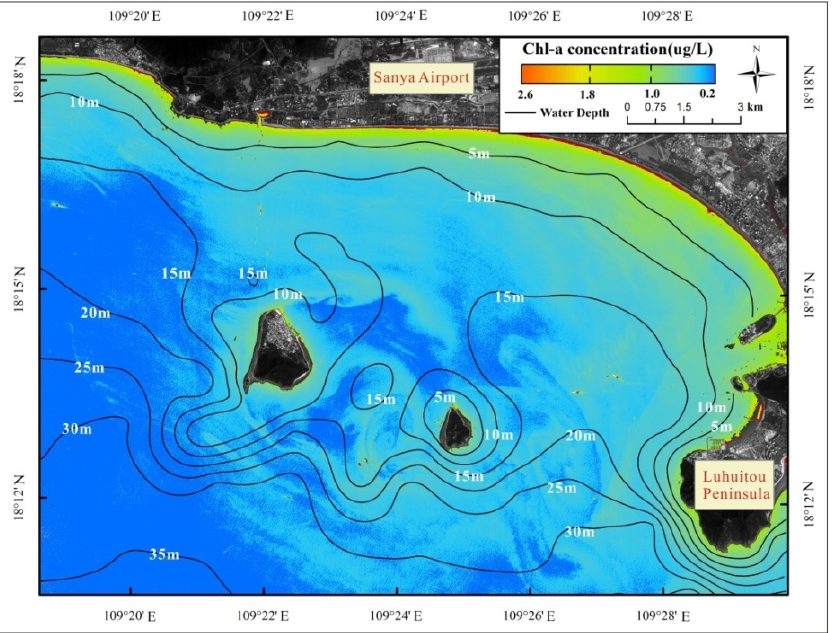
Figure 25. Chl-a concentration retrieval using a phy (490) in SYB.